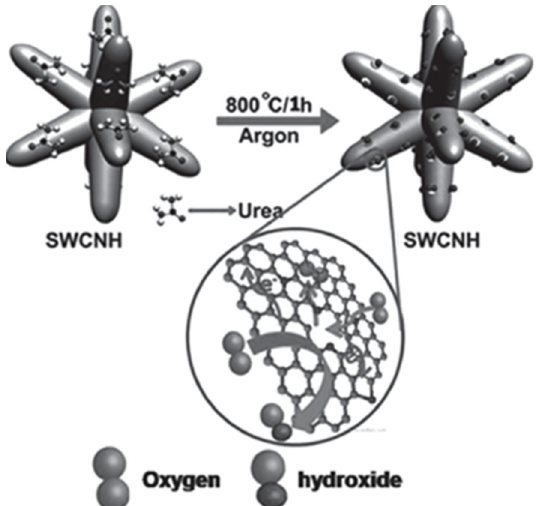
Figure 3. A schematic representation of the synthesis of nitrogen-doped SWCNH by treatment with urea at high temperature. The inset shows the active centers formed around the pore openings, which facilitates the oxygen-reduction reaction. Reproduced with permission of [43]; John Wiley and Sons,